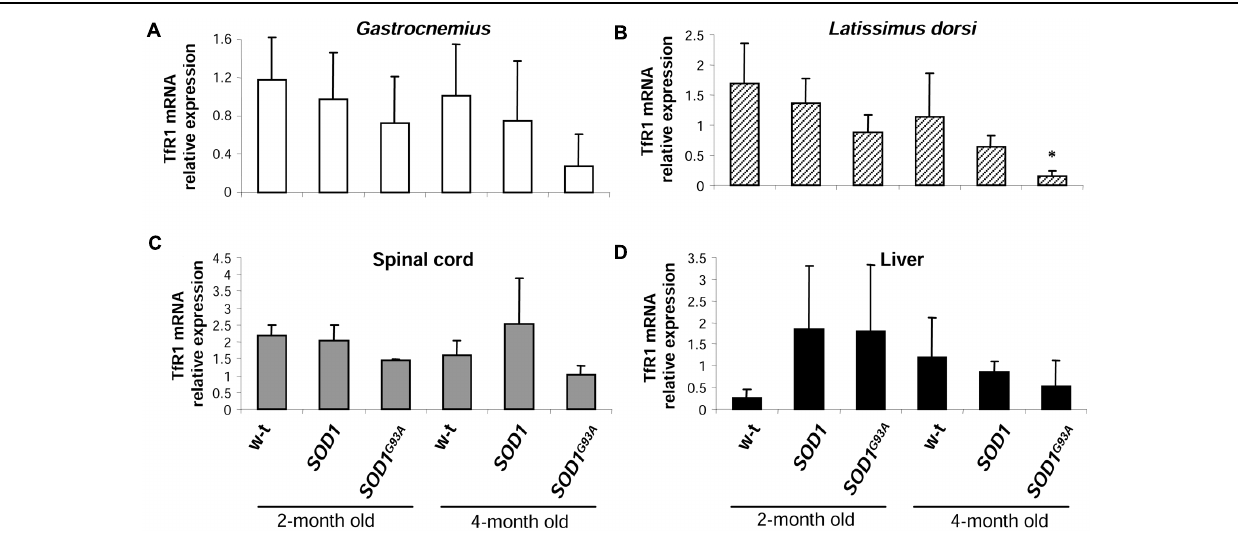
FIGURE 6 | Analysis of TfR1 mRNA abundance in tissues of experimental mice. TfR1 mRNA abundance in skeletal muscles (A,B) , spinal cord (C), and liver (D) was measured by real-time RT-PCR as described under “Materials and methods.” The histograms display TfR1 mRNA levels after normalization to 18S ribosomal RNA levels. Each column represents the mean ± SD of three biological amplification reactions. RNA from each mouse was extracted separately using TRIZOL reagent, reverse-transcribed and amplified as described in M&M; therefore, 18 cDNA samples (biological triplicates for each condition) were finally used in the analysis of gene expression in each tissue. ∗ , significant difference versus wild-type in the group of symptomatic, 4-month-old mice ( P <